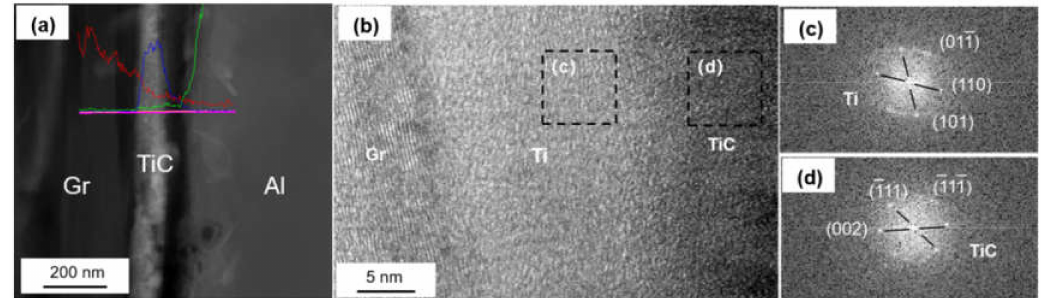
Figure 4. ( a ) Interface morphology of the Ti-coated Graphite/Al prepared by focused ion beam (FIB); ( b ) high resolution transmission electron microscope (HRTEM) image of Ti-coated graphite surface; ( c , d ) fast Fourier transform (FFT) of ( b ).